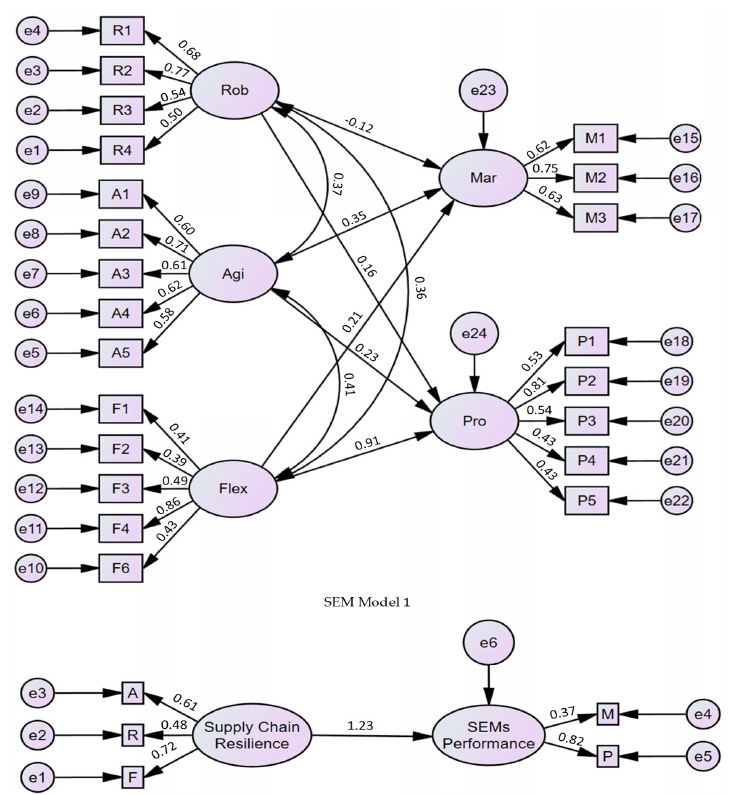
Figure 2. Structural Equation Modeling 1 and 2.